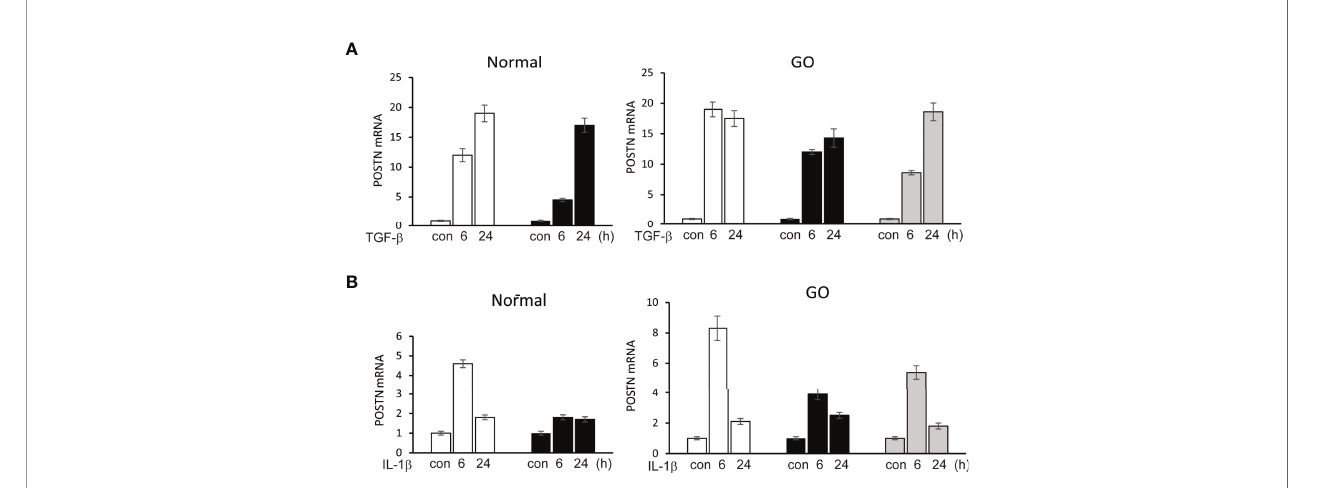
FIGURE 2 | Upregulation of POSTN gene by stimulation of TGF- b and IL-1 b . (A) TGF- b (5 ng/ml) upregulated expression of POSTN gene in a time-dependent manner in both normal (n=2) and GO (n=3) cultured orbital fi broblasts in real time PCR analyses. (B) POSTN gene expression was increased when cells were treated with 10 ng/ml of IL-1 b for 6 h in normal (n=1) and GO (n=3) cultured orbital fi broblasts. The folds for the mRNA values are shown for RT-PCR.